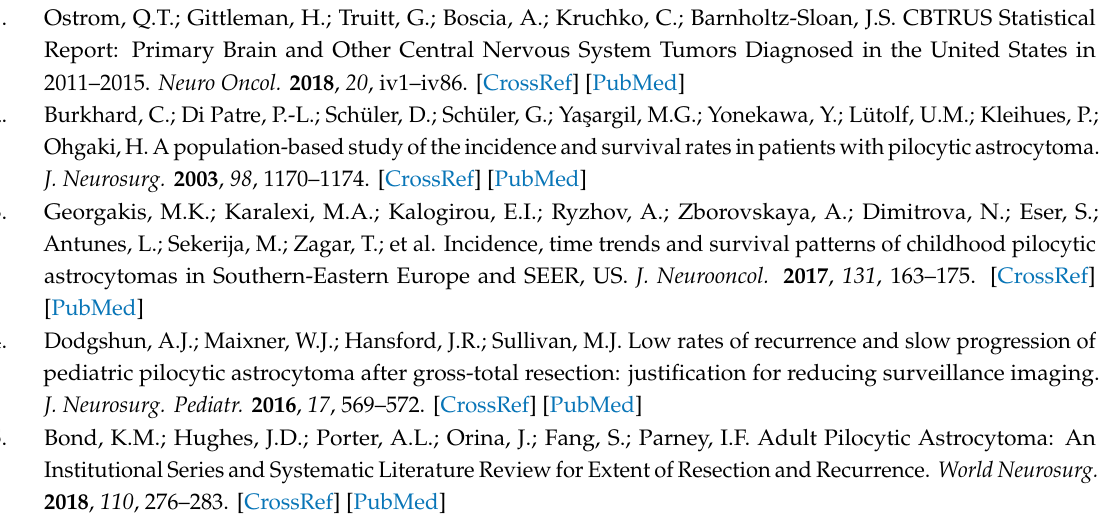
Table S1: Institutional Cohort of Adult Pilocytic Astrocytomas (n = 58): Demographic, Tumor, Molecular and Treatment Characteristics and Patient